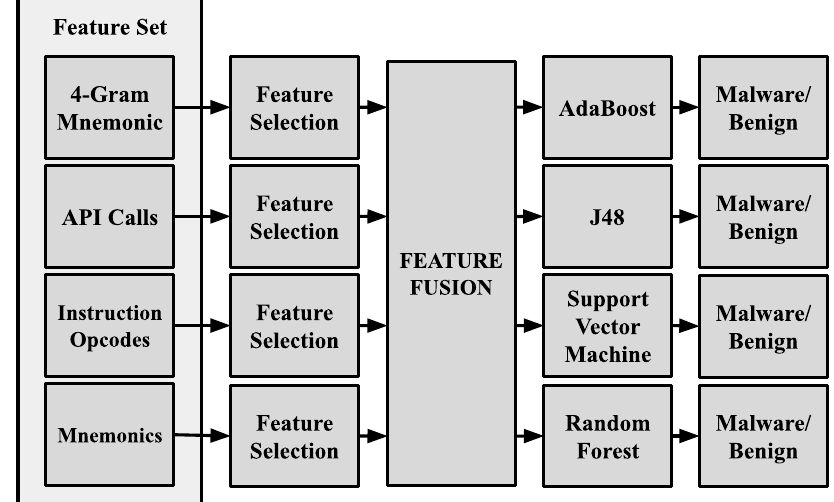
Figure 8. Multimodal architecture for feature fusion